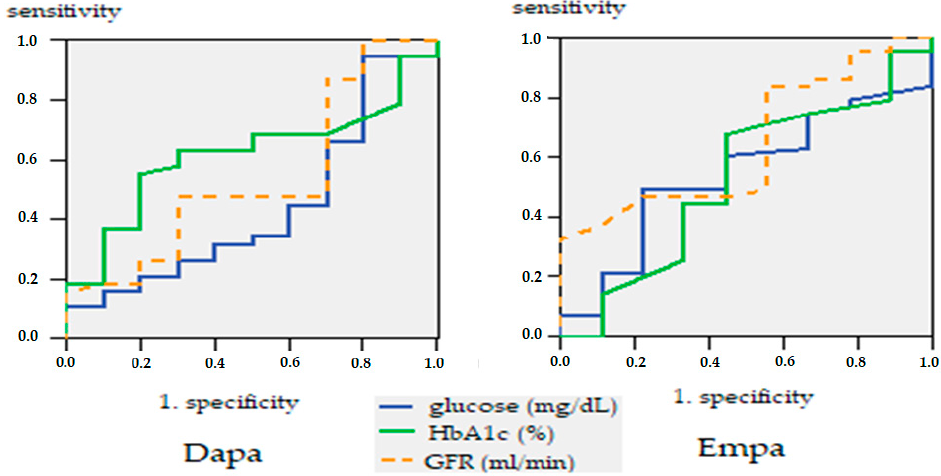
Figure 8. ROC curve, glucose, HbA1c and GFR are predictors of heart failure.